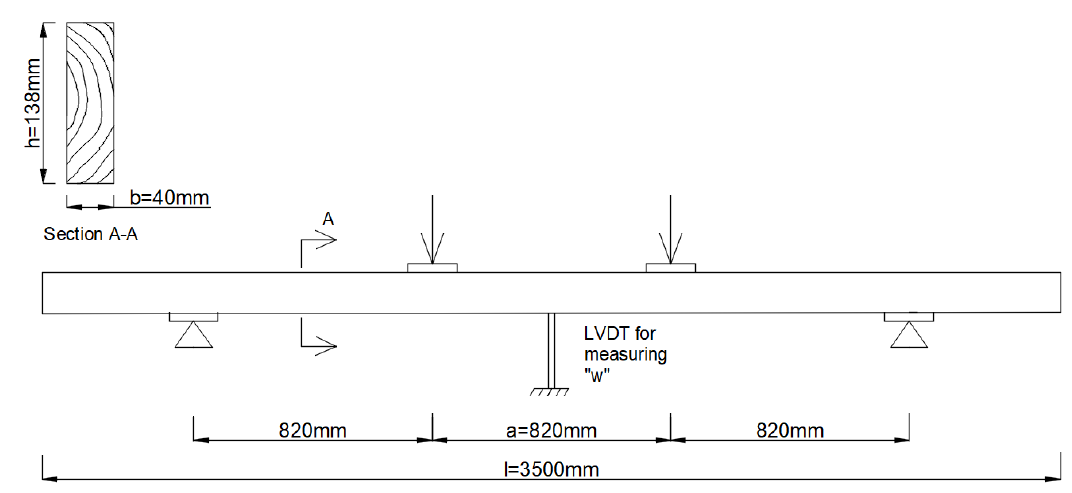
Figure 2. Static diagram of a four-point structural timber bending test to determine MOE and MOR in line with EN 408 [26]: w—deflection.